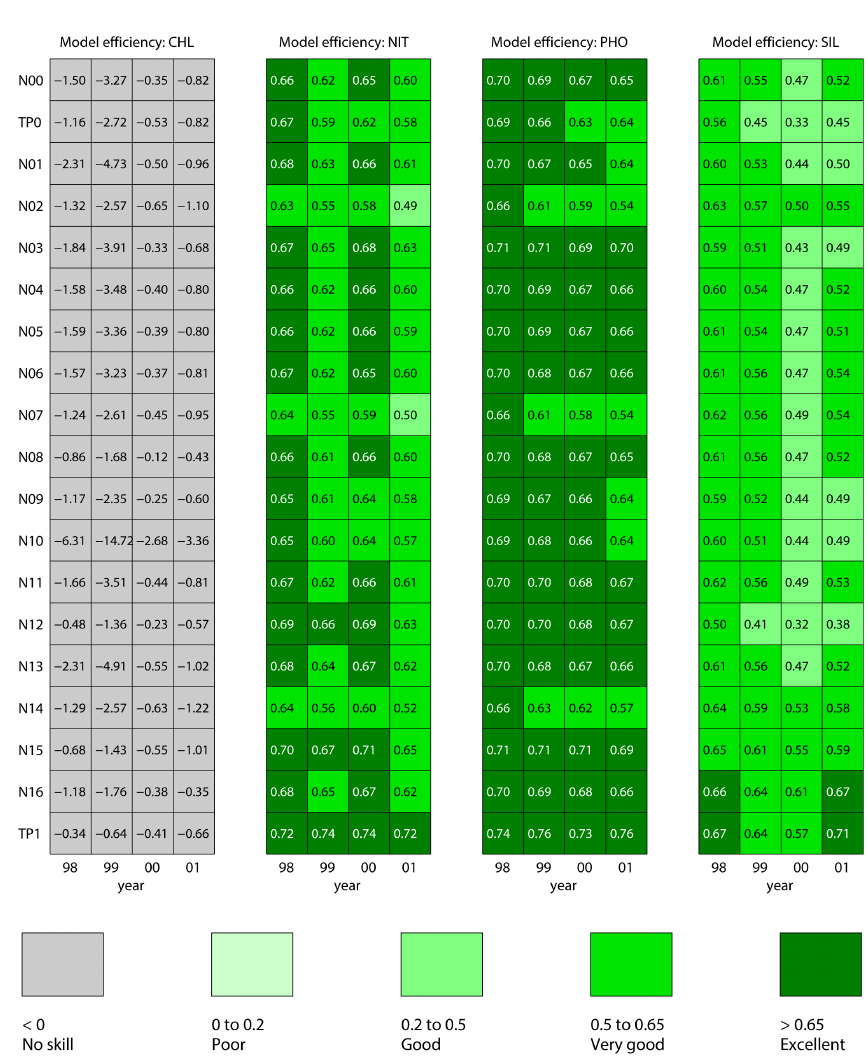
Figure 5. Model efficiency (ME, see text) for the model simulations compared to all available observations from the period